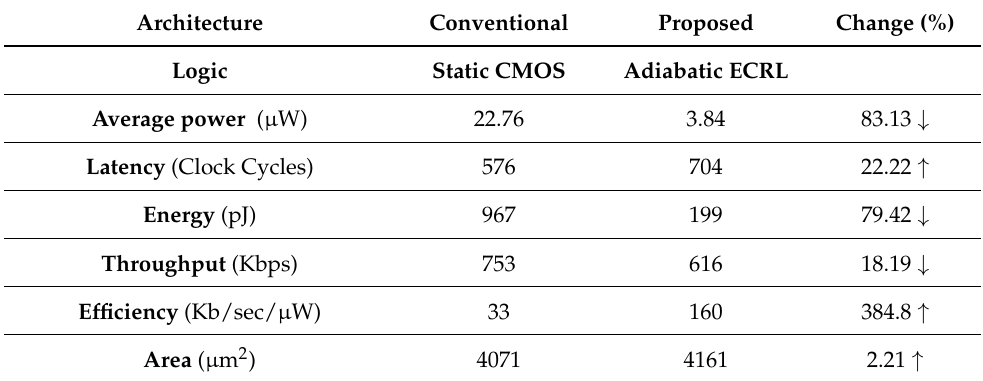
Table 2. Post-layout simulation results of the bit-serialized SIMON32/64 cipher implemented in conventional and proposed adiabatic